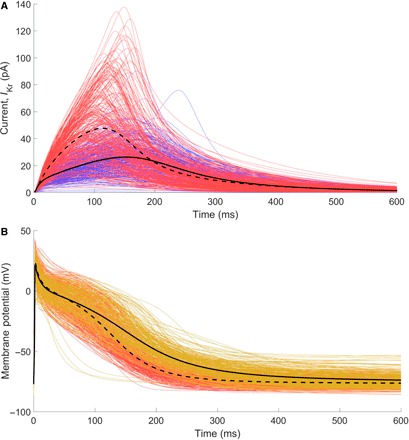
Calibration to distributions produces models that respond appropriately to antiarrhythmic treatment via IKr block.(A) Traces of the rapid component of the delayed rectifier K+ current for the models calibrated to the SR data set (blue, solid) and the cAF data set (red, dashed). The cAF population demonstrates an almost twofold increase in the activity of this current. (B) APs after treatment by 50% IKr block (gold) show significant AP prolongation compared to the same models without IKr block (red). This is also demonstrated by the averaged traces for both (black lines: treated, solid; untreated cAF, dashed). The restoration of atrial refractoriness in patients with cAF is demonstrated.